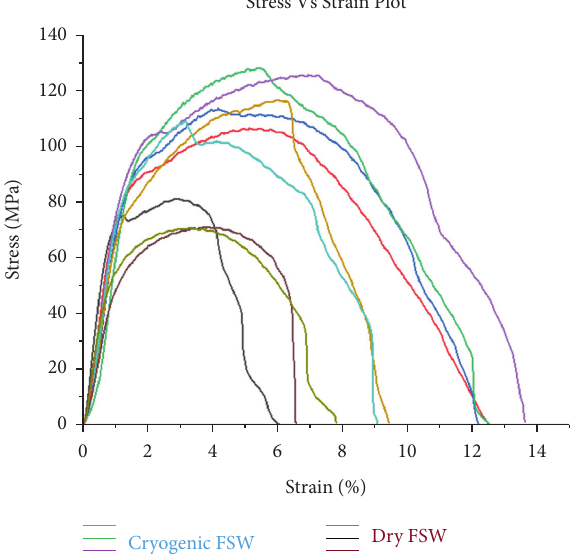
Figure 15: Stress-strain diagram, for the friction stir-welded sample in the dry and cryogenic condition for AA 7075 aluminium alloy.